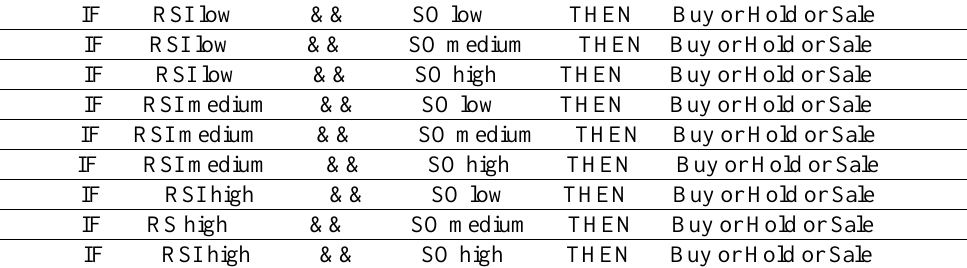
Table 1. All extractable rules in the